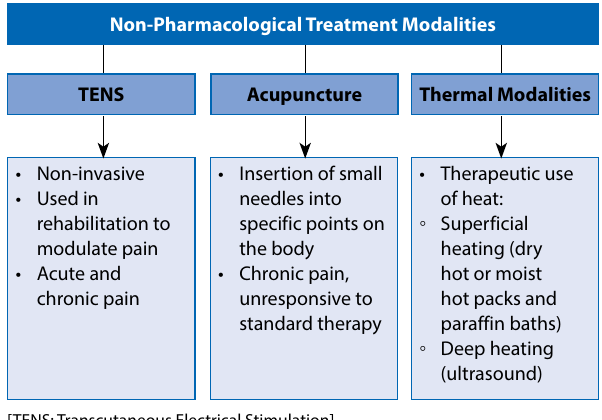
Figure 1 : Non-pharmacological treatments of muscle